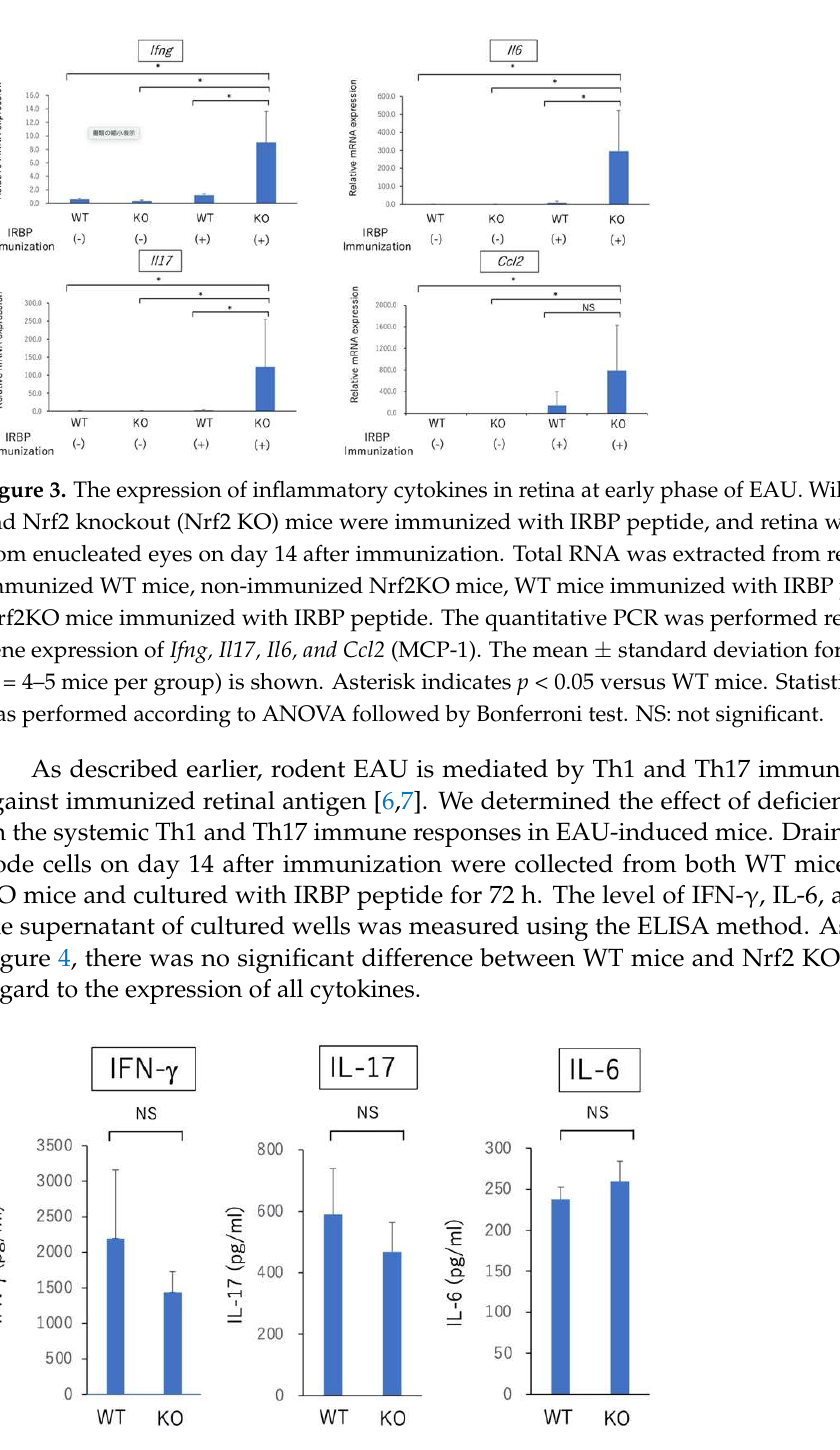
Figure 4. In vitro analysis of Th1 and Th17 immune responses of draining lymph node cells in EAU-induced WT mice and Nrf2 KO mice. Wild type (WT) and Nrf2 knockout (Nrf2 KO) mice were immunized with IRBP peptide and draining lymph node cells were collected on day 14 after immunization and pooled within groups. Each group consisted of 4 mice. The draining lymph node cells were cultured with IRBP peptide for 72 h. The level of IFN- γ , IL-6, and Il-17 in supernatant of cultured wells was measured using ELISA method. The mean ± standard deviation for each group ( n = 4 wells per group) is shown. Statistical analysis was performed according to Student’s t test. NS: not significant.